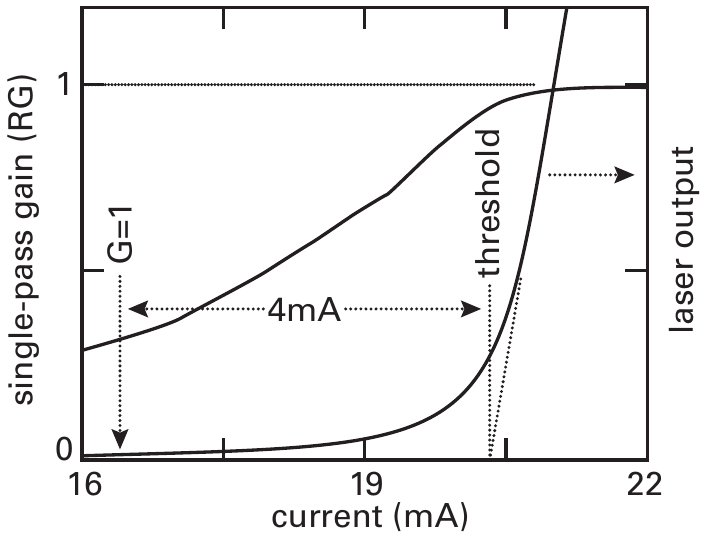
Figure 1. Measured RG product and output power for a GaAs TJS laser. Note the exponential rise and saturation near threshold of the single-pass gain, consistent with the expression for the single pass gain, Equation (8). A better measure of threshold would be to find the intersection of the below-threshold and above-threshold output versus pumping (LI) curves or to find the location of the maximum of the second derivative of the LI curve. The slight difference is not material here. Adapted from Figure 4 of [22], with the permission of AIP publishing.